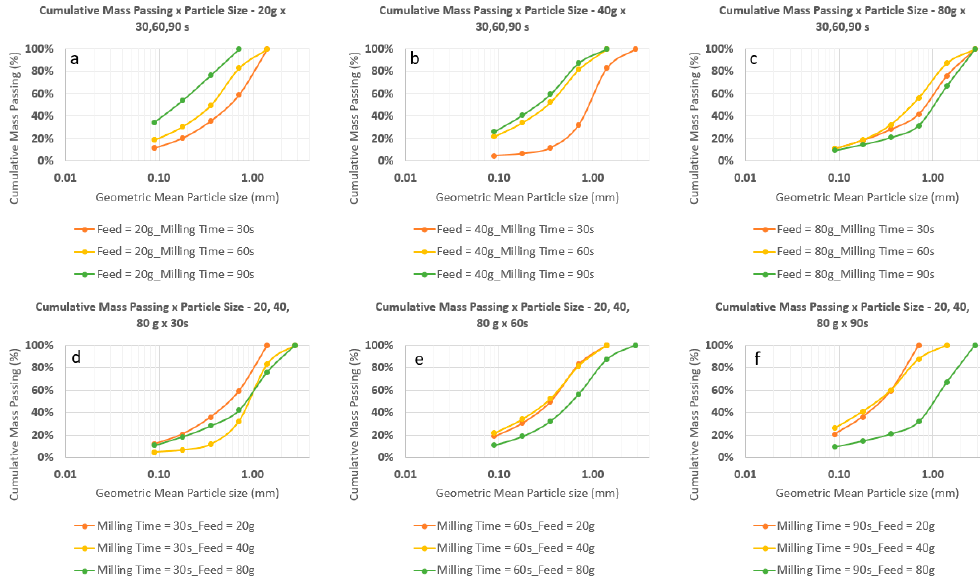
Figure 3. Particle size distribution of hammer mill products from 2–4 mm feed. ( a ) 20 g feed, ( b ) 40 g feed, ( c ) 80 g feed, ( d ) 30 s milling time, ( e ) 60 s milling time, and ( f ) 90 s milling time.